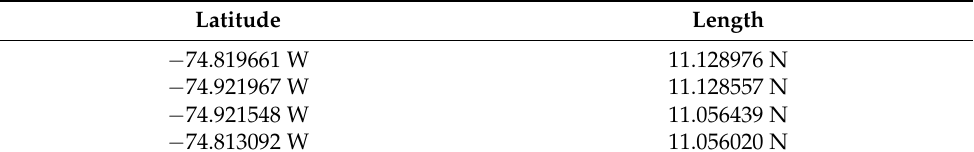
Table 1. Study area coordinates.